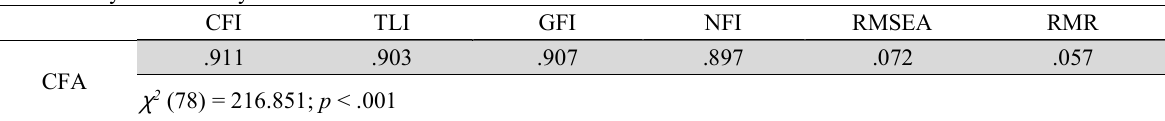
Confirmatory Factor Analysis Result